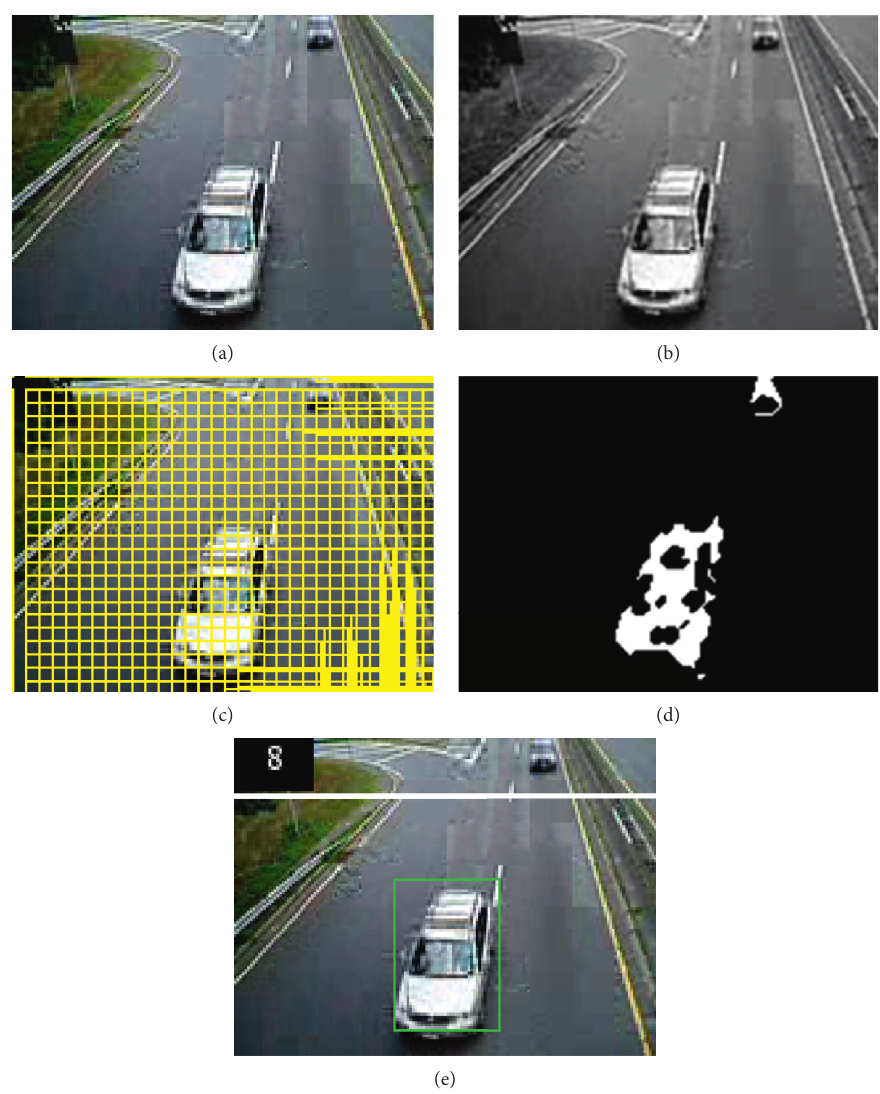
Figure 8: Detection result of the 100 th frame. (a) The original image. (b) Grayscale image. (c) Optical flow vector. (d) Morphological filtering. (e) Test